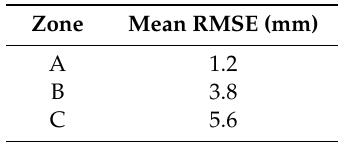
Table 1. Mean RMSEs of the three zones.